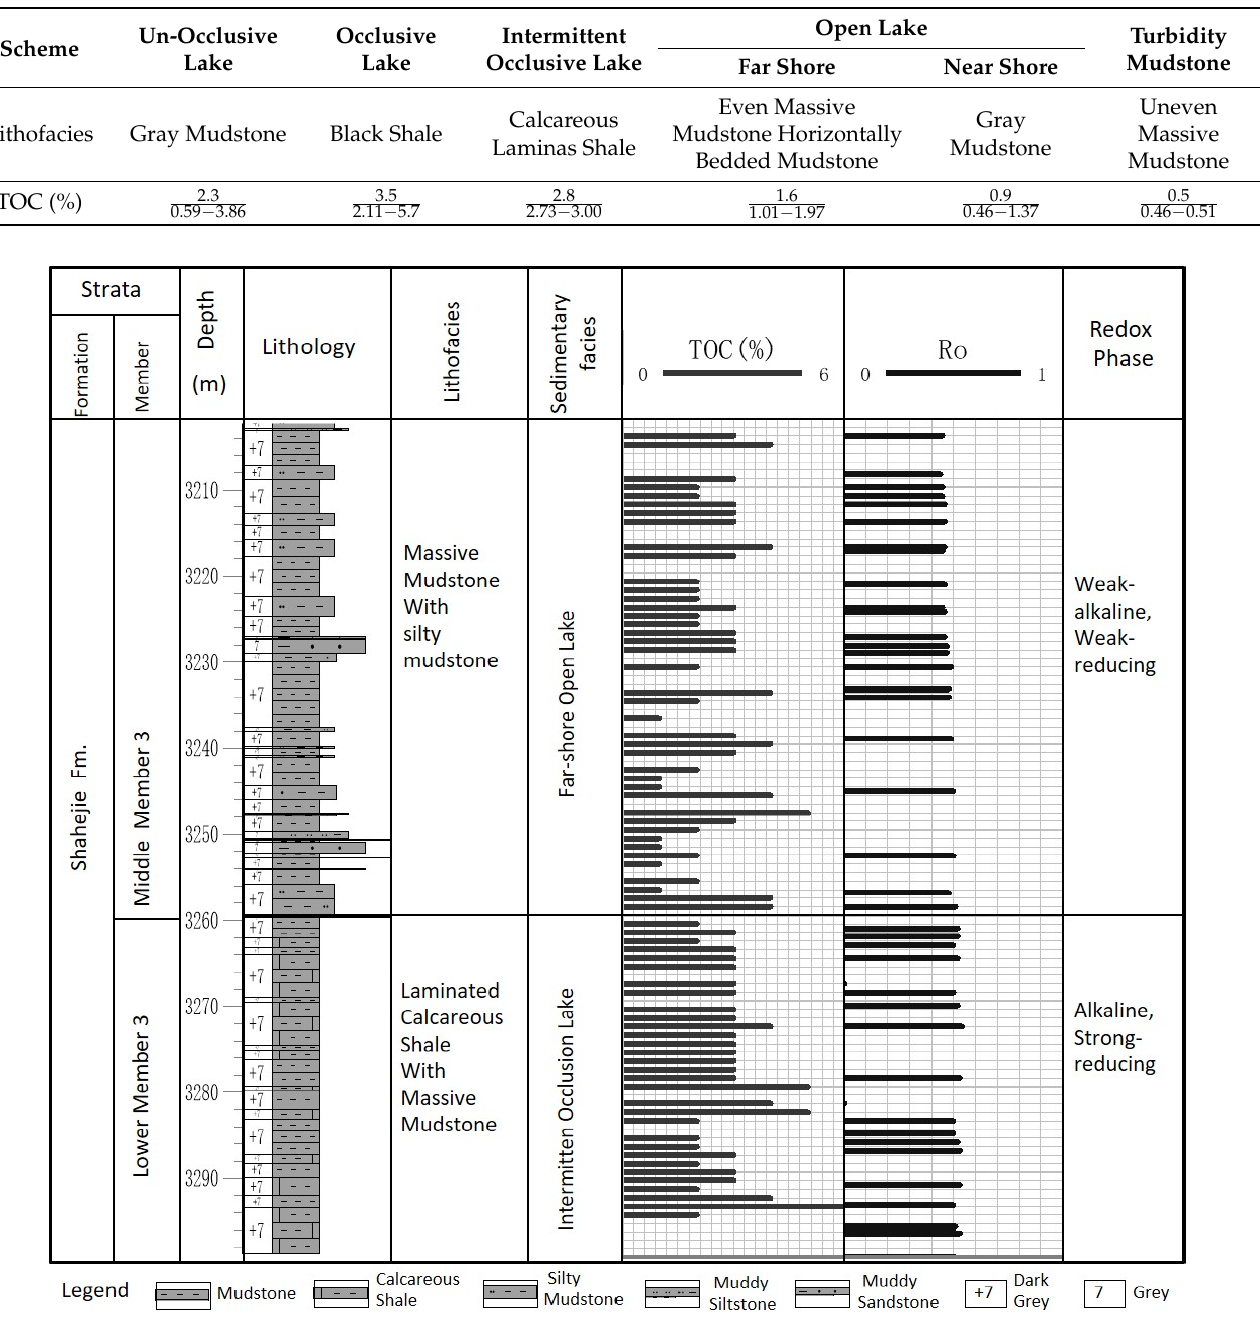
Figure 3. TOC content changes in different lithofacies and sedimentary environments in Well Niu 38, Dongying.